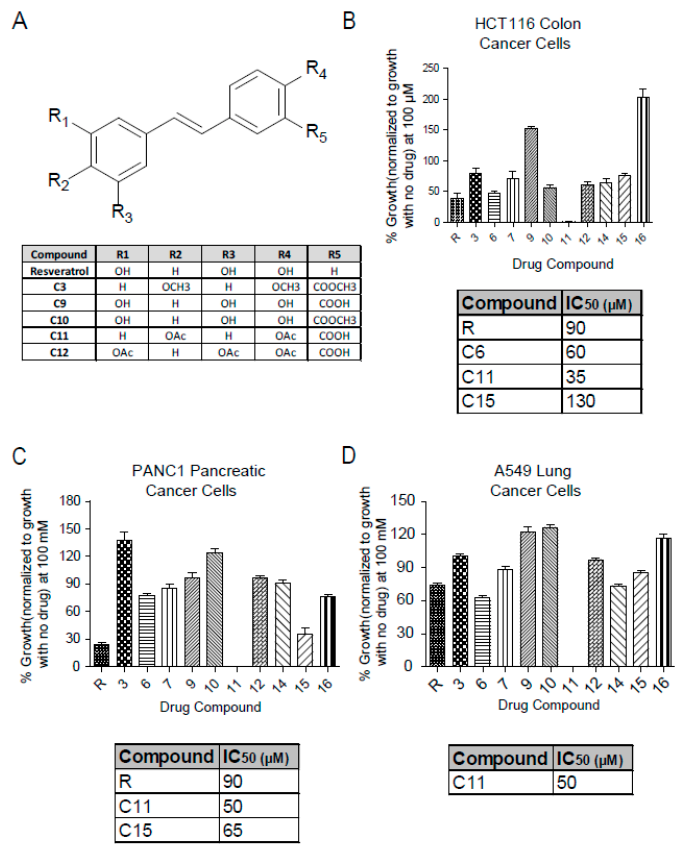
Figure 1. Chemical structure of resveratrol and derivatives and their effect on cell viability. ( A ) Table showing the chemical structure of parent compound resveratrol and some of the derivatives obtained from Dr. Carlos Velazquez Martinez from the Pharmacy department at the University of Alberta (For full chemical structures and preparation please see Reference [24]) ( B – D ) Analysis of cell viability with resveratrol and derivatives at 100 µM in colon cancer (HCT-116), pancreatic cancer (PANC1), and lung cancer (A549) cell lines. For IC 50 calculation, cells were treated with concentrations between 0 to 200 µM (only effective compounds summarized in a table and can be seen in Supplementary Figure S1). N = 8–16 with p values from < 0.05 to 0.001 for comparisons of compounds with resveratrol. If not stated, p -value > 0.05. One-way ANOVA analysis of ( B – D ) revealed significance with p values < 0.0001.